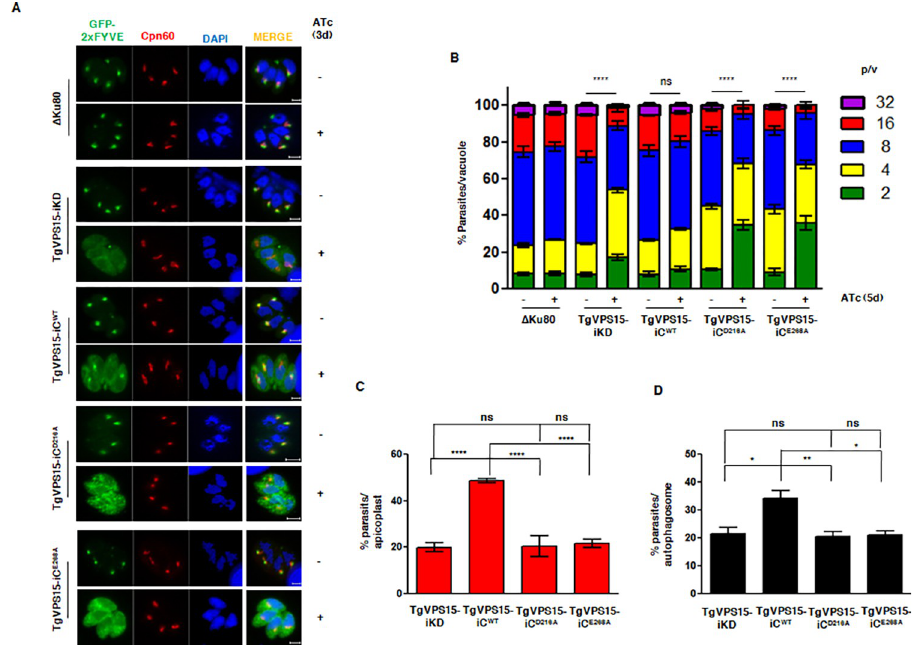
Fig 7. Role of catalytic site residues in the TgVPS15 function. A. DD-GFP-2xFYVE was expressed in TgVPS15-iKD parasites or these parasites complemented with a copy of Ty-tagged WT TgVPS15, or its D216A or E268A mutants. Subsequently, parasites were treated with ATc for 72h (3d) or left untreated. Prior to fixation, Shield-1 was added for 30 minutes to stabilize the expression of GFP-2xFYVE. IFA was performed using anti-Cpn60 antibody. The image of only those parasites in which apicoplast was present is shown. While WT TgVPS15 complementation restored PI3P formation indicated by 2xFYVE staining at the apicoplast, majority of parasites complemented with D216A and E268A exhibited diffuse 2xFYVE in the cytoplasm. B. TgVPS15-iKD parasites were complemented with a copy of Ty-tagged WT TgVPS15 or its D216A and E268A mutants. The indicated parasite lines were preincubated for 96h or 4d in culture medium in the presence (+) or absence (-) of ATc and were subsequently allowed to invade fresh HFFs in the presence or absence of ATc. The number of parasites per vacuole was determined after 24h. Data represent mean ± SE, n = 3 and at least 200 vacuoles were counted for each condition (n = 3, ���� , P < 0.0001, ANOVA, 8p/v, ns-not significant). C. The indicated parasite lines were pre-treated with ATc for 4d and IFA was performed using anti-Cpn60 antibody after additional 24h (S6 Fig). % parasites containing the apicoplast were determined by counting parasites in IFA images (S6 Fig). Data represent mean ± SE, n = 3, �� P < 0.01, ANOVA, ns-not significant. D. GFP-ATG8 was ectopically expressed in indicated parasite lines. Parasites were treated with ATc for 2d and extracellular tachyzoites were either cultured in complete (0h) or HBSS medium (8h). Subsequently, parasites were fixed and analyzed by fluorescence microscopy (S7 Fig). GFP-ATG8 positive autophagosomes were counted from at least 50 parasites and % parasites possessing autophagosomes was determined (Mean ± SE, n = 3, � P < 0.05, �� P < 0.01, ANOVA, ns-not